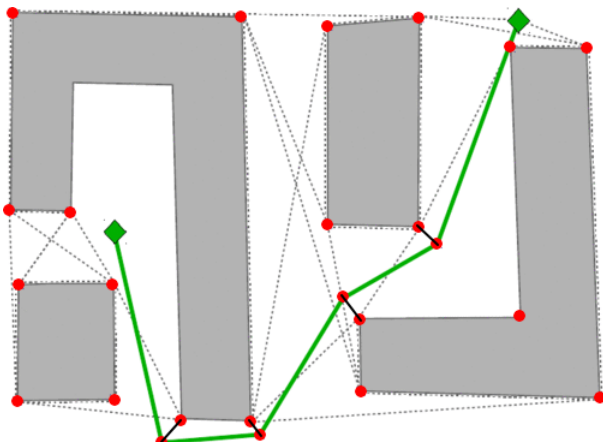
Figure 5. Final result of the path-finding algorithm using the visi- bility graph created by the preprocessing tool (APT-P). The dots at the obstacle corners mark the nodes of the graph, and connections between these nodes, annotated with a cost to travel, are indicated by dashed lines. The left/right rhombus visualizes the starting/end point of the path to go, which is illustrated by green lines that are connected at the shifted navigation points. The outward shift of the original nodes toward the actual navigation points is visualized by black